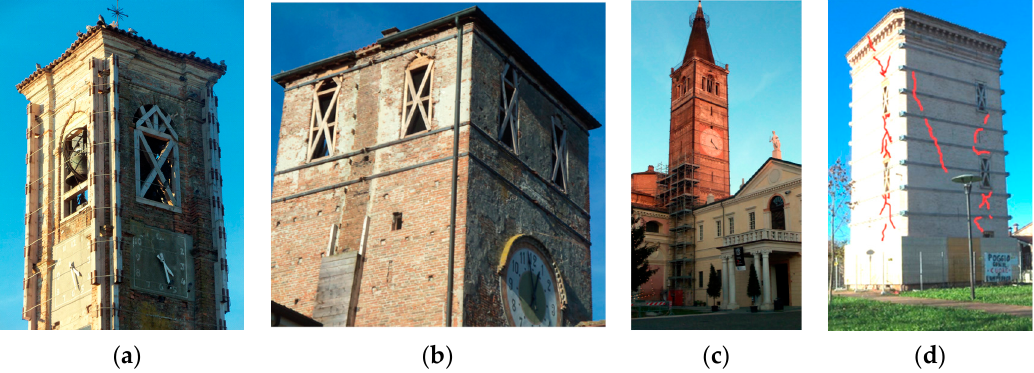
Figure 1. Examples of seismic damage of towers: damage of the belfry ( a ); ( b ) damages caused by the several discontinuities; ( c ) the adjacent structures complicate the structural behaviours, ( d ) the position of the openings and the effects of the past interventions ( d ).